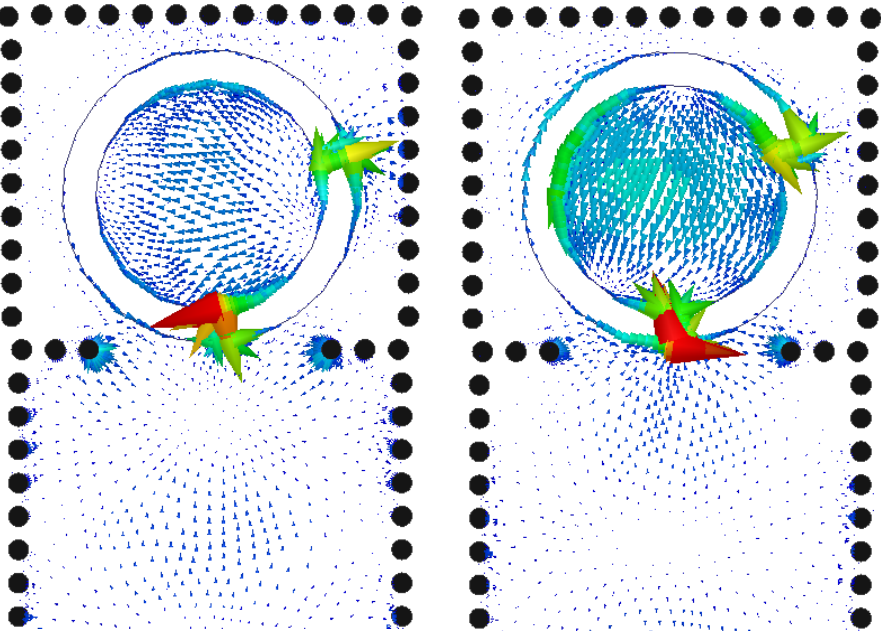
Figure 3. Surface current-density on the top metal surface (including circular-patch) of the proposed antenna at 34 GHz. With excitation phase of ( a ) 0° and ( b ) 90° .